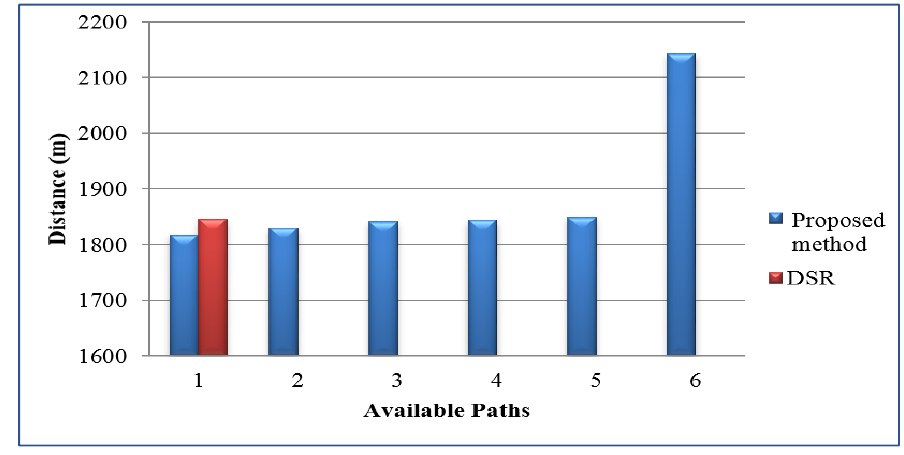
Figure 13. Selected path.